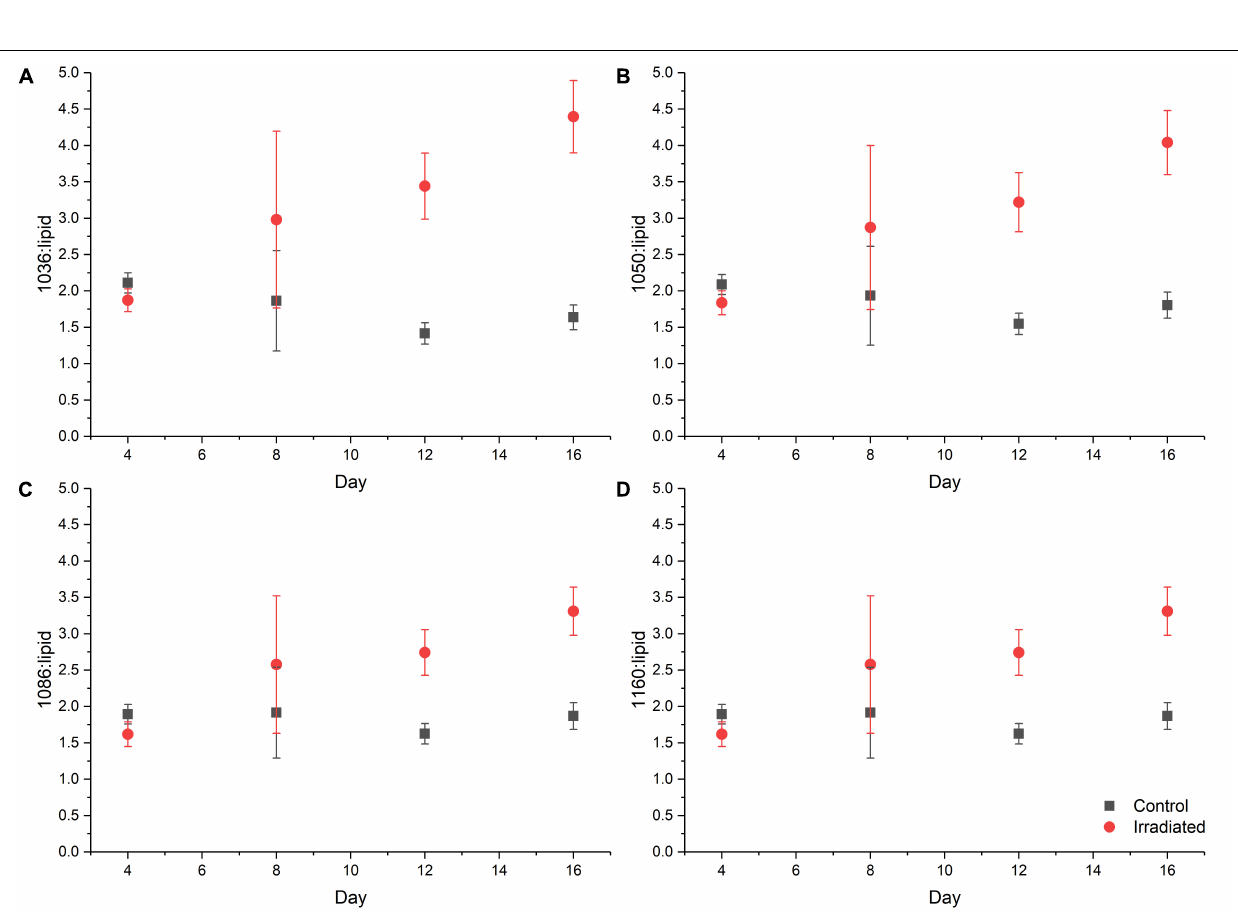
Frontiers in Microbiology |